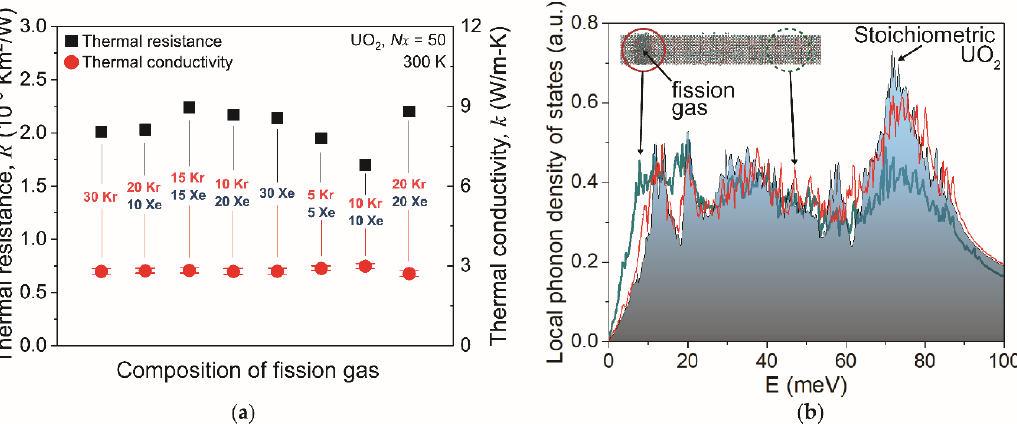
Figure 9. ( a ) Interfacial thermal resistances and thermal conductivities of UO 2 with fission gas bubbles as a function of the composition of fission gas. ( b ) Local phonon density of states (PDOS) in UO 2 with a fission gas bubble.